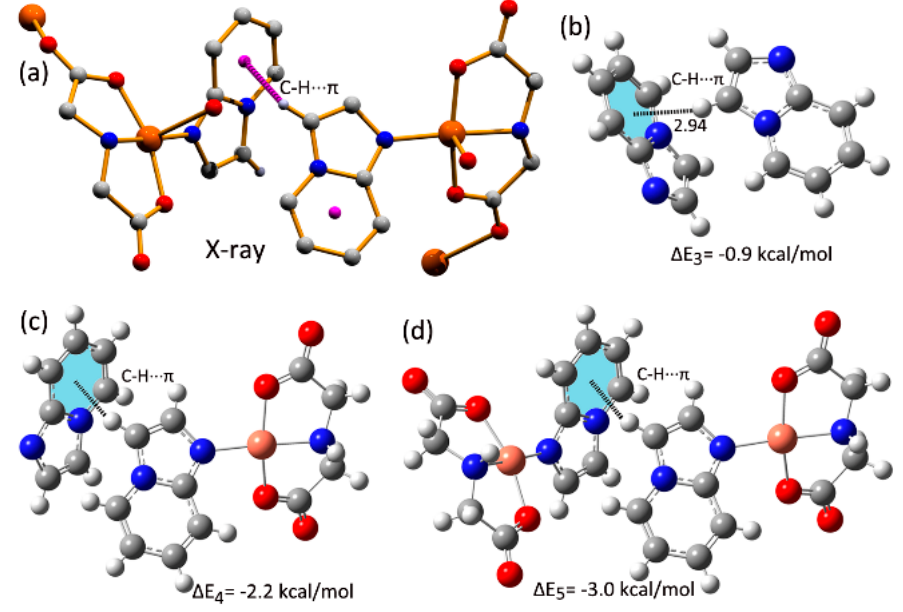
Figure 8. ( a ) X ‐ ray fragment. ( b – d ) Theoretical models used to estimate the C–H ∙∙∙π interaction.